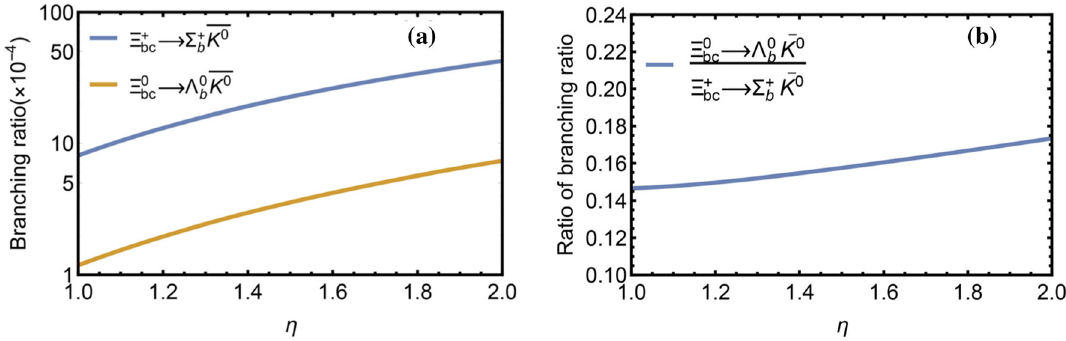
¯ ¯ → (cid:20) + → (cid:5) 0 K 0 and (cid:2) 0 K 0 in logarithmic coordinates. b ratio of branching bc b bc b